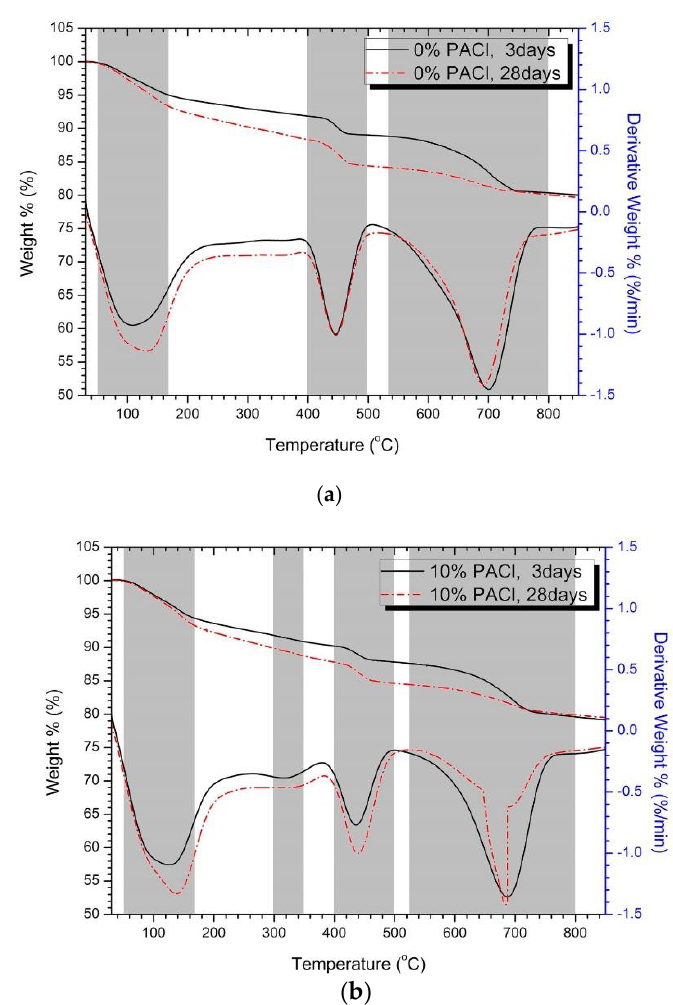
Figure 7. Results of thermogravimetric and differential thermogravimetric analysis: ( a ) 0% PACl, ( b ) 10% PACl.